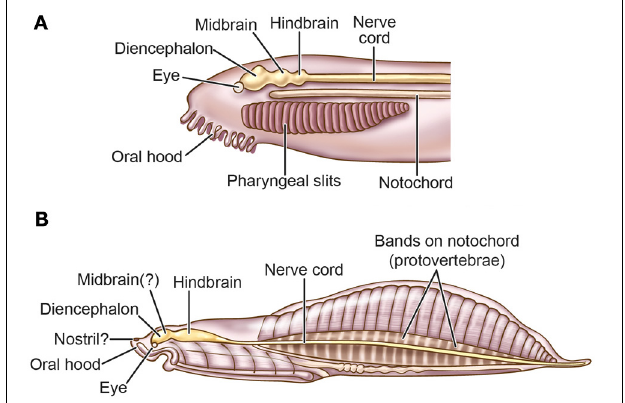
FIGURE 5 | Nervous systems of pre-vertebrates. (A) The “cephalate” as hypothesized by Butler (2000, 2006; Butler and Hodos, 2005). (B) Haikouella . This fossil animal is interpreted to have had paired eyes, less prominent or absent olfactory organs, a poorly developed telencephalon, and no otic or vestibular organs (Mallatt and Chen, 2003; Chen, 2009, 2012). Mallatt and Chen (2003) propose that Haikouella supports Butler’s model of the hypothetical